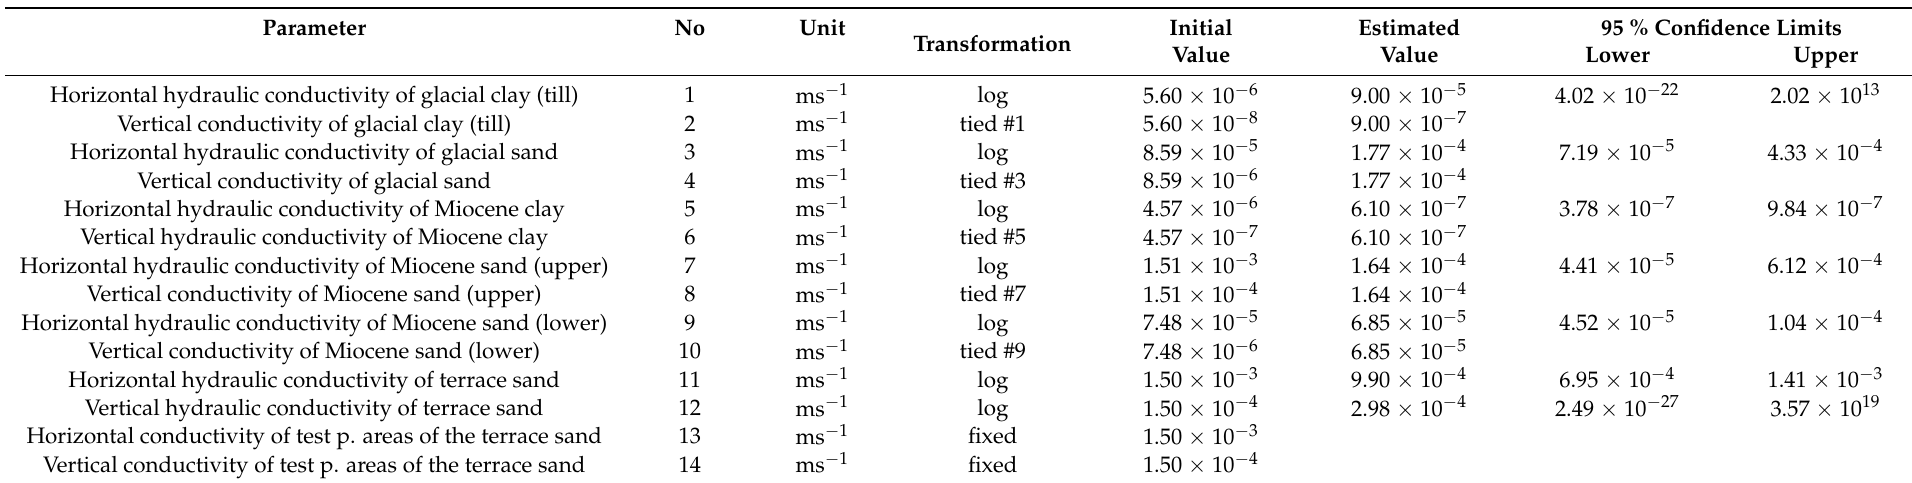
Table A2. Calibration of Post audit-Geology